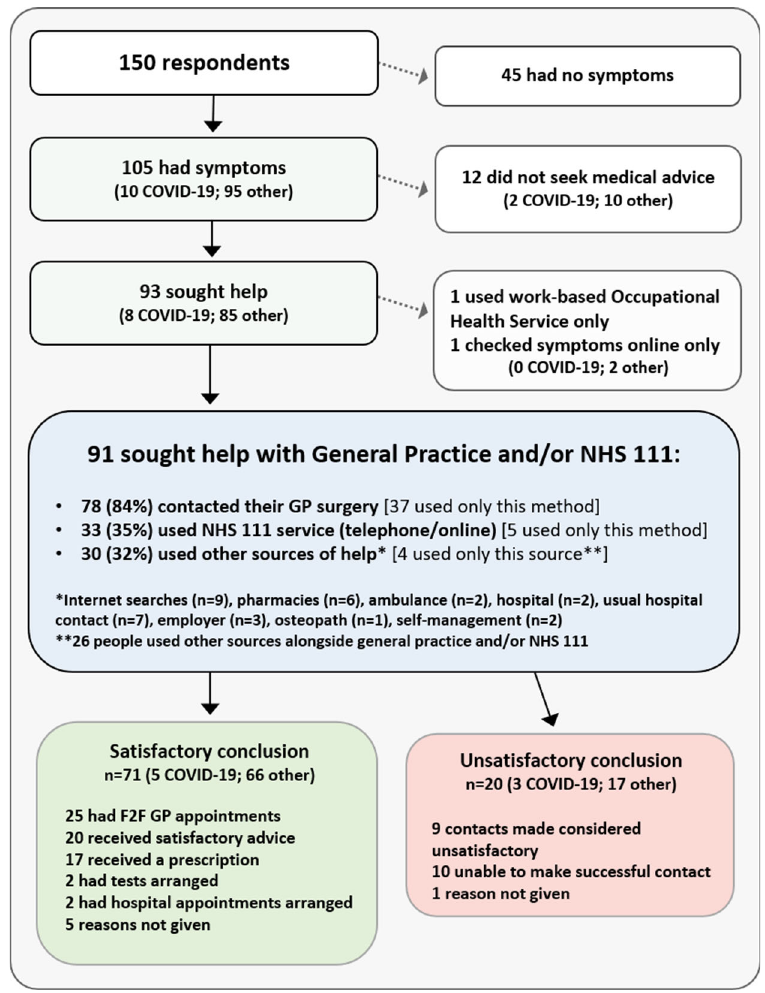
Figure3.SurveyArespondents ’ useofhealthcare,March-Sept2020. NHS111isanationaltelephonehelplineand website for